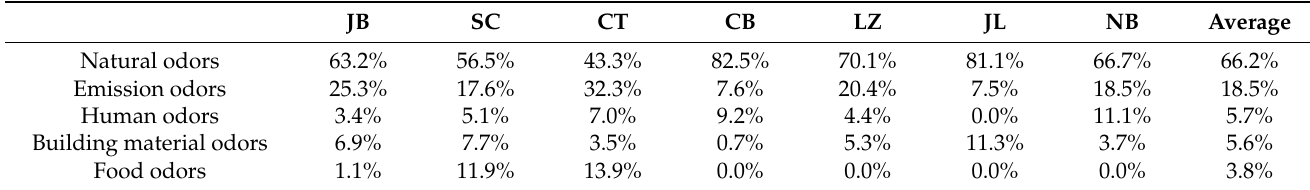
Table 7. Average proportions of five categories of odors in seven WSMCs.